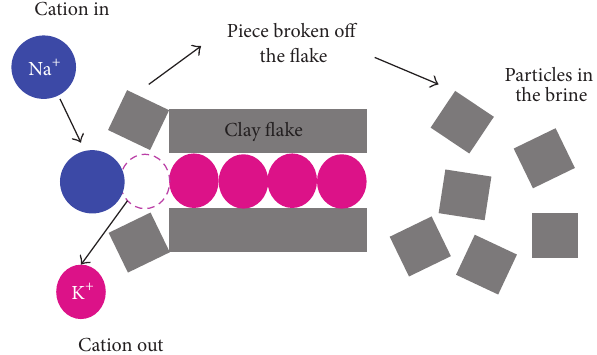
Figure 1: Schematic explanation of the Reed [20] mechanism for particle generation by mica alteration during exposure to low- potassium brine (modified from Civan [39]). Reed assumed that the ionic radius of Na + was larger than that of K + .